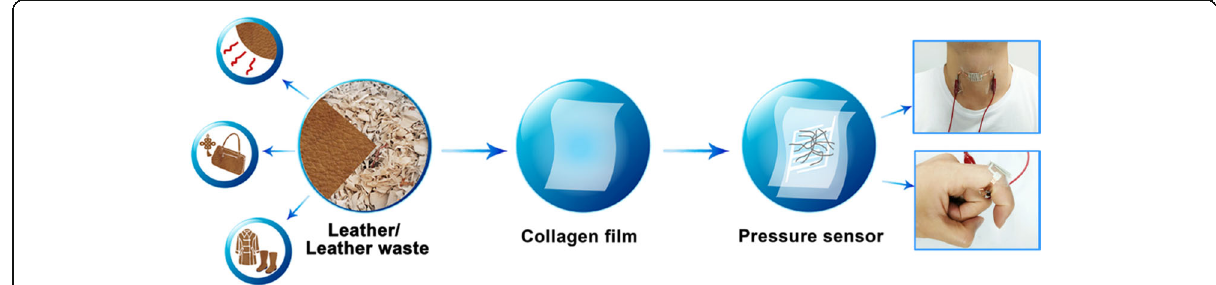
in IL ([BMIM] Cl, 1-butyl-3-methylimidazolium chloride) and regenerated in precipitant (DI water) (Additional file 1: Figure S2). The dissolution mechanism of the col- lagen fibers in [BMIM] Cl can be found in Fig. 1a. Accord- ing to the electron donor-electron acceptor (EDA) theory, the [BMIM] Cl is dissociated at high temperature and the free Cl − acting as electron donor would associate with the hydrogen in the amino group, and the free [BMIM] + act- ing as electron acceptor would complex with the oxygen in the carboxyl group, the process of which would disrupt hydrogen bond between the collagen macromolecule chains and lead to the dissolution of the whole collagen [33]. In addition, [BMIM] Cl can be completely miscible with the deionized water while collagen cannot, so during the regeneration process, the hydrogen bond can be re- built between collagen chains as the [BMIM] Cl has been washed away. However, the quantity and position of some hydrogen bond differ from that of the original collagen due to the changing position of the collagen chains during the regeneration process, resulting in the change of struc- ture and properties of regenerated collagen films. The collagen fibers and regenerated collagen films are firstly studied by using Fourier-transform infrared (FT-IR) analysis (Fig. 1b). The peak of Amide A (3308 cm − 1 ) rep- resents N-H stretching vibration absorption, which relates to the hydrogen bonds between the collagen